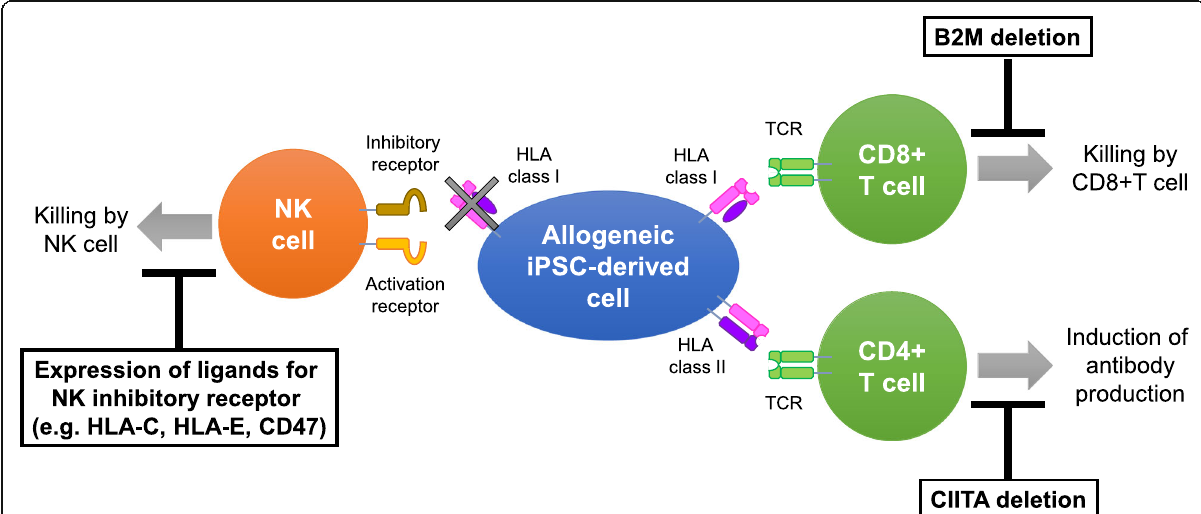
Fig. 1 Schematic representation of the mechanisms for allogeneic iPSC-derived cells to evade immunological rejection. Allogeneic iPSC-derived cell are recognized and eliminated by allo-reactive T cells through HLA class I and class II molecules. Deletion of HLA class I and class II are achieved by B2M and CIITA gene deletion, respectively. On the other hand, loss of HLA class I molecules, which function as ligands for NK inhibitory receptors, causes attack by NK cells. To avoid killing by NK cells, expressions of NK inhibitory ligands, such as HLA-C, HLA-E and CD47 have been